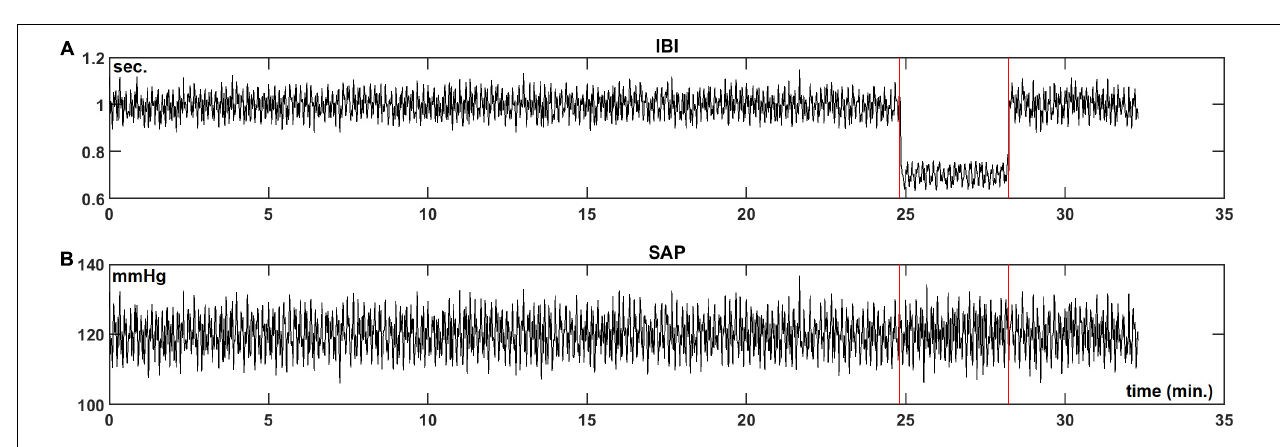
FIGURE 6 | Simulated IBI (A) and SAP (B) data as described in section “Materials and Methods.” In the simulation, during the “HUT”-period (25 to 28.5 min) the mean IBI is decreased from 1.0 to 0.7 s and the vagal influence is reduced.